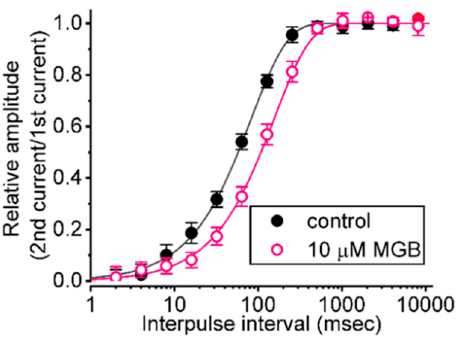
Figure 4. Effect of MGB on the recovery of I Na(T) inactivation evoked by varying interpulse intervals with a geometric progression. In these recording experiments, we kept cells bathed in Ca 2+ -free Tyrode’s solution, while the recording pipette was backfilled with K + -enriched solution. The examined GH 3 cells were depolarized from − 80 to − 10 mV for a duration of 30 ms, and subsequently different interpulse durations with a geometric progression (indicated in the upper part) were delivered to them. The time course of recovery from I Na(T) inactivation taken in the absence of (filled black circles) and presence (open pink circles) of 10 μ M MGB is illustrated. The relative amplitude of peak I Na was measured as a ratio of the second peak amplitude divided by the first peak amplitude peak. The recovery time course (indicated by the smooth line) in the absence of and presence of 10 μ M MGB displays an exponential rise as a function of the interpulse interval, with a time constant of 83.2 and 156 ms, respectively. Of note, the x -axis is illustrated with a logarithmic scale. Each point is the mean ± SEM (n = 7).